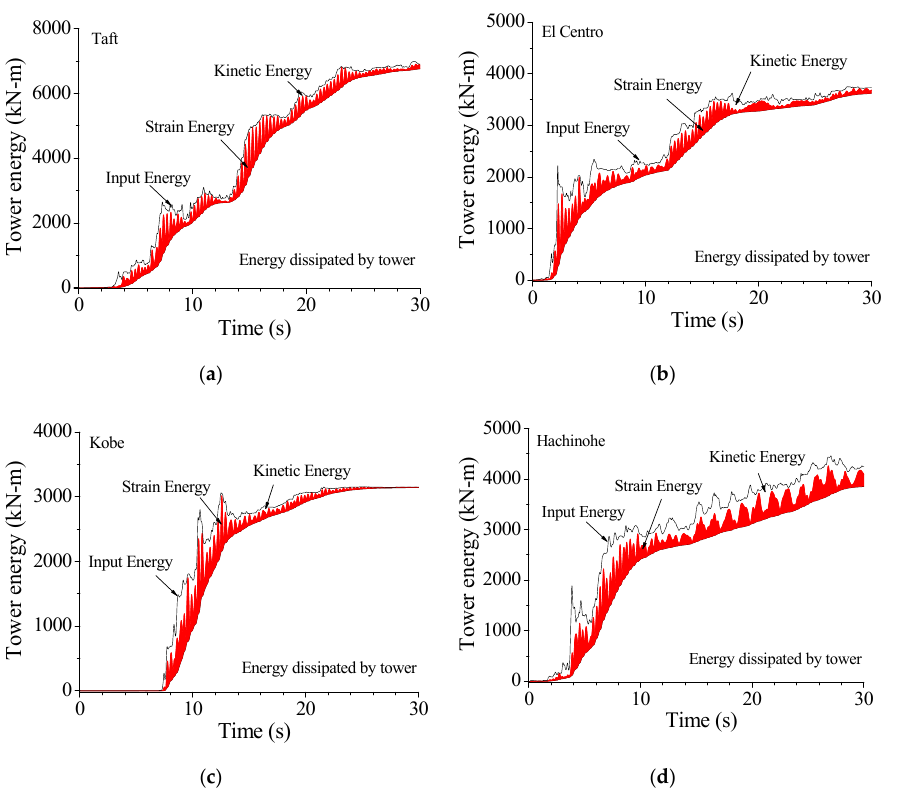
Figure 18. Energy responses of the tower without friction dampers. ( a ) Taft; ( b ) El Centro; ( c ) Kobe; ( d ) Hachinohe.